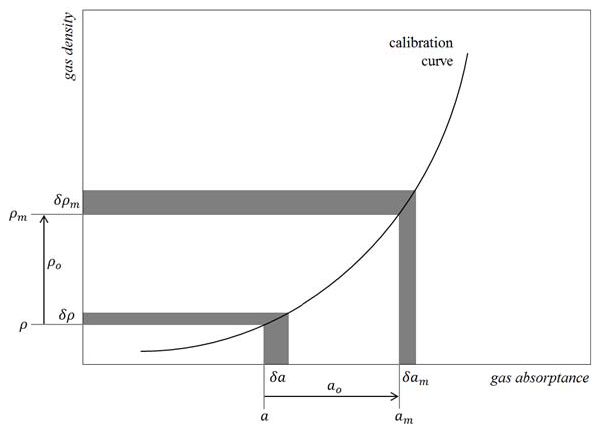
Fig. 2. Conceptual visualization of how a zero bias in gas absorp- tance ( a 0 ) yields an accuracy bias in gas density ( ρ 0 ) as well as a precision bias in the evaluation of density fluctuations ( δρ m 6= δρ) . Note that δa m < δa in Eq. (11). The curvature of the calibration curve, the magnitude of absorptance bias, and the attenuation of δa m relative to δa are all exaggerated for the purpose of illustra-